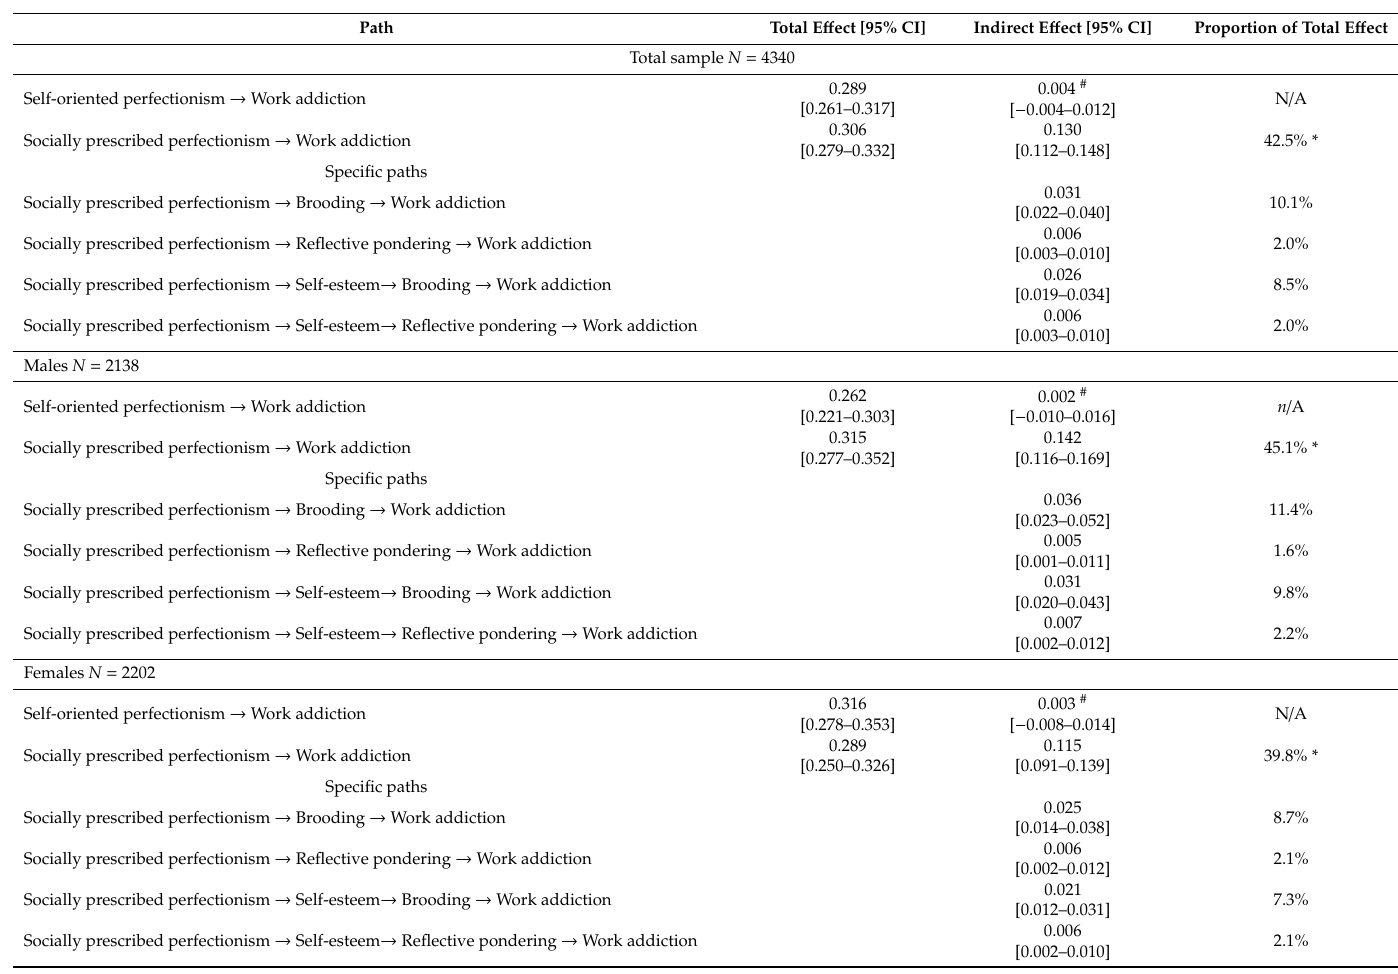
Table 2. Standardized estimates of the direct and total indirect e ff ects on the risk of work addiction and mediator variables and their respective confidence